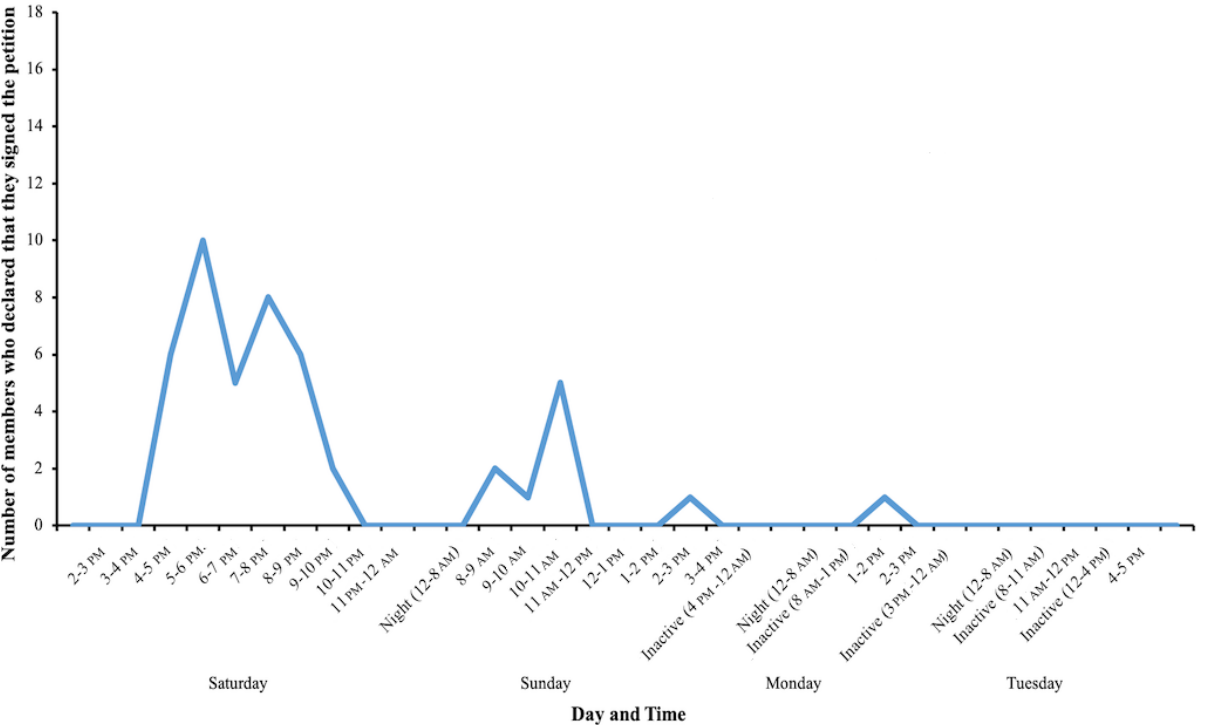
Figure 2. Number of members and the time distribution of their messages declaring they signed the